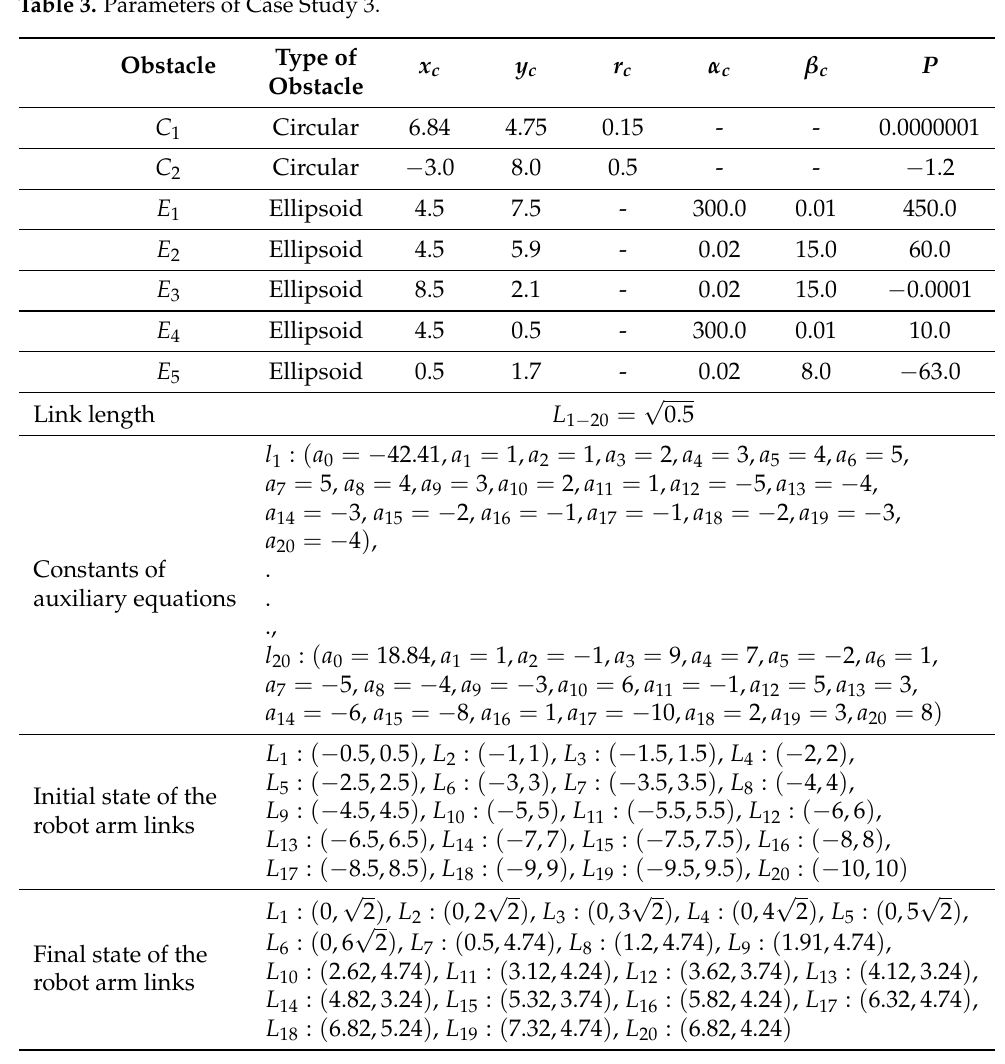
Table 3. Parameters of Case Study 3.